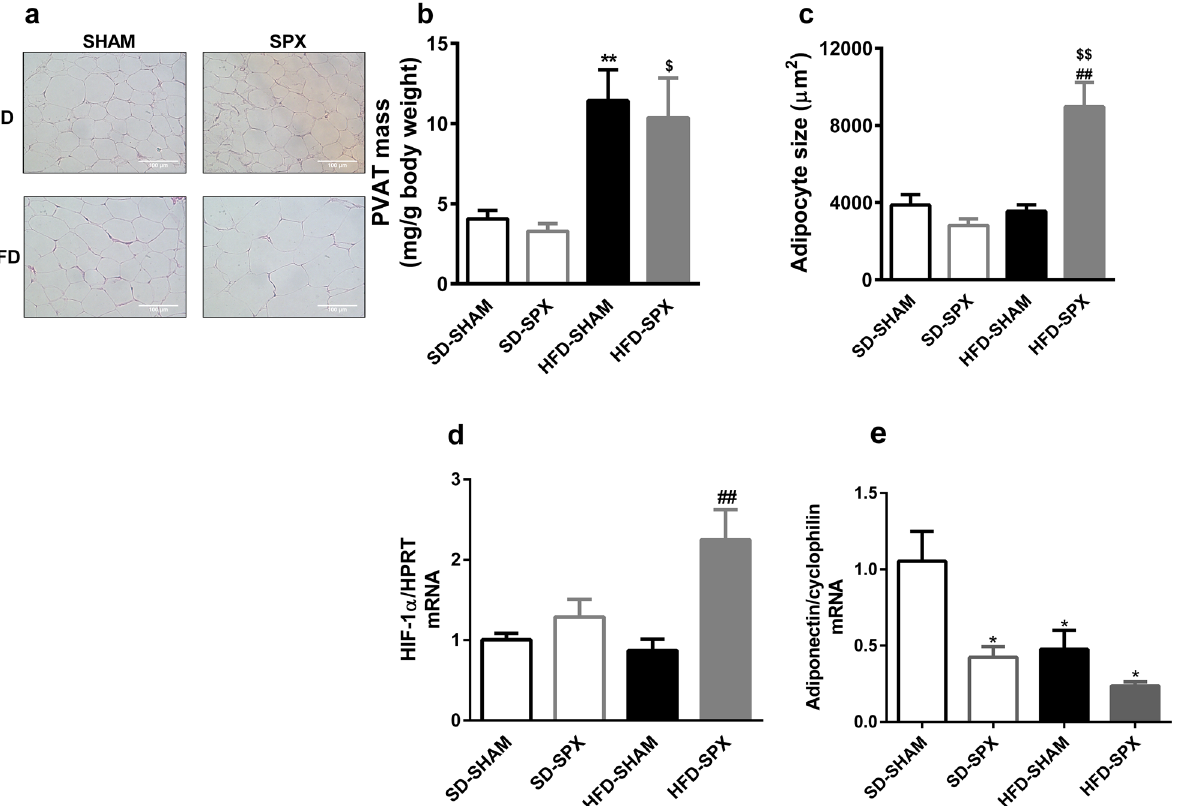
Figure 2. Splenectomy promoted adipocyte hypertrophy in mesenteric PVAT (mPVAT) of mice fed a high-fat diet (HFD). ( a ) Representative histological images, ( b ) mass, ( c ) adipocyte size, ( d ) HIF-1 α mRNA levels and ( e ) adiponectin mRNA levels in mPVAT from sham-operated (SHAM) or splenectomized (SPX) mice fed with standard diet (SD) or HFD. (n = 4 per group and n = 8 to 10 per group for PVAT mass). Data were expressed as mean ± SEM. ANOVA: * P < 0.05 and ** P < 0.01, SD-SPX and HFD-SHAM versus SD-SHAM; $ P < 0.05 and $$ P < 0.01, HFD-SPX versus SD-SPX; ## P < 0.01, HFD-SPX versus